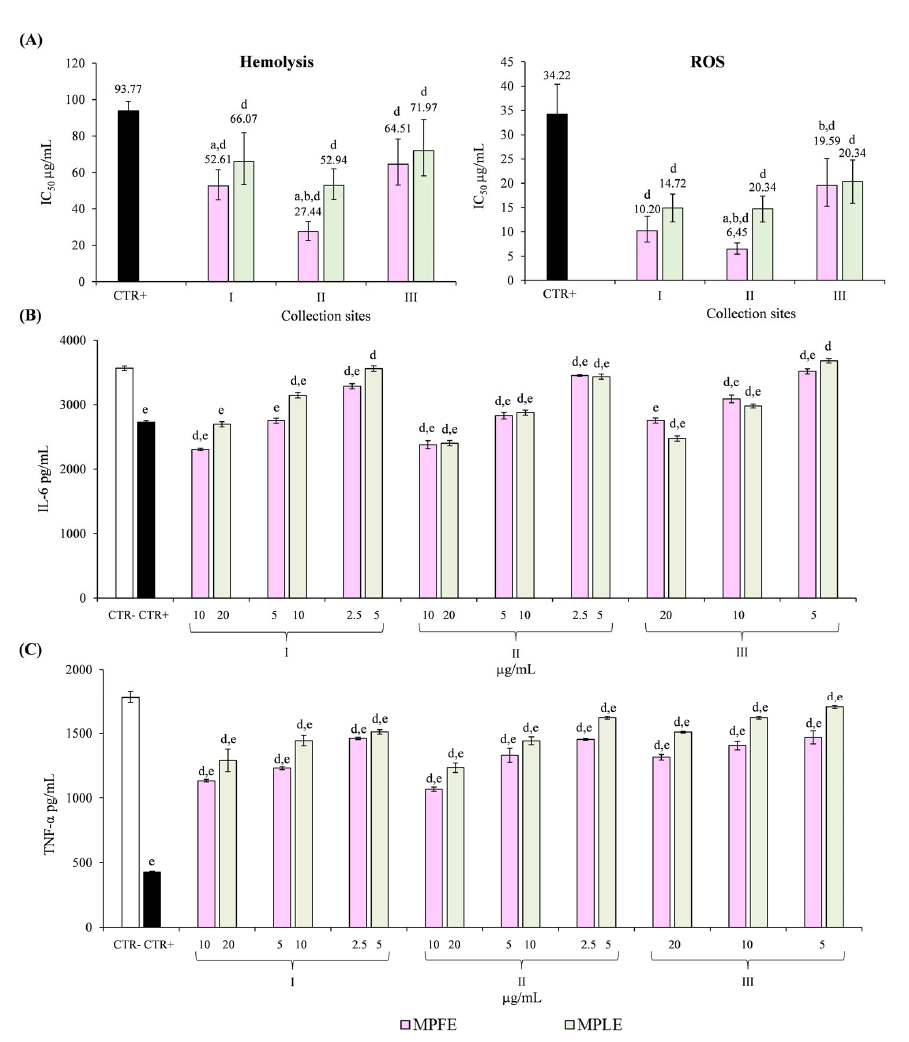
Figure 7 . Antioxidant and anti ‐ inflammatory activity of leaf and flower extracts of M. pulegium (MPLE and MPFE, respectively) investigated by in vitro cell ‐ based assays carried out on erythrocytes ( A ) and peripheral blood mononuclear cell (PBMC, panel ( B , C )). ( A ) Heat ‐ induced hemolysis, diclofenac sodium (50.0–200.0 μ g/mL) was used as positive control (CTR+); free ‐ radical scavenging activity against intracellular ROS, trolox was used as positive control (CTR+); ( B , C ) IL ‐ 6 and TNF ‐α release by PBMC after 10 ng/mL LPS ‐ induced inflammation; diclofenac sodium 50 μ g/mL was used as positive control (CTR+), whereas cell medium culture containing 0.1% DMSO was used as negative control (CTR ‐ ). a p < 0.001 vs. respective MPLE; b p < 0.001 vs. other MPFE; c p < 0.001 vs. other MPLE d p < 0.001 vs. CTR+; e p < 0.001 vs. CTR ‐ .